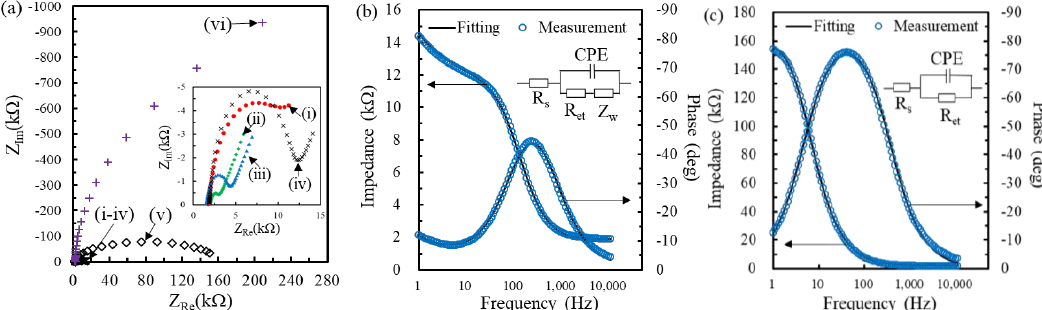
Figure 2. ( a ) Nyquist plots obtained at the Au electrode in a 26 mM N-[Tris(hydroxymethyl)methyl]-2-aminoethanesulfonic acid (TES) buffer containing 1 mM equimolar Fe(CN) 63−/4− before and after the modification of MHA:MCH (mM) mixture of 0:1 (ii), 0.02:1 (iii), 0.04:1 (iv), 0.1:1 (v) or 1:0 (vi). Bode plots measured at the MHA (0.04 mM)/MCH(1 mM) ( b ) and MHA (0.1 mM)/MCH(1 mM) ( c )-modified electrodes. Inset of ( b ) and ( c ) respectively shows the diagram of modified Randles equivalent circuit and 1R//C circuit.